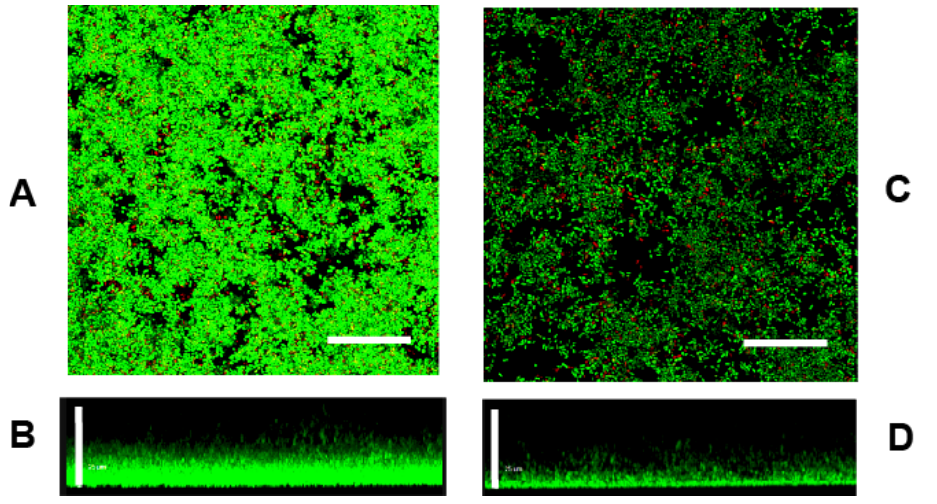
Figure 3: Bacterial biofilms observed by confocal microscopy. Bacteria are allowed to adhere to a solid plastic surface where they grow and connect among themselves. After development of the biofilm, the bacteria are stained with dyes that allow differentiating between live cells (green fluorescence) and dead ones (red fluorescence). A young actively growing biofilm with a small amount of dead cells is shown in the left panels, whereas an old biofilm disintegrating is depicted to the right. Note the density (panels A and C ), and the thickness (panels B and D ) of both biofilms. The photographs show three-dimensional reconstructions of horizontal ( A , C ) and vertical ( B , D ) scans (40 at the x–y plane, and 68 scans at the x–z plane). The scale bar is 25 µm.